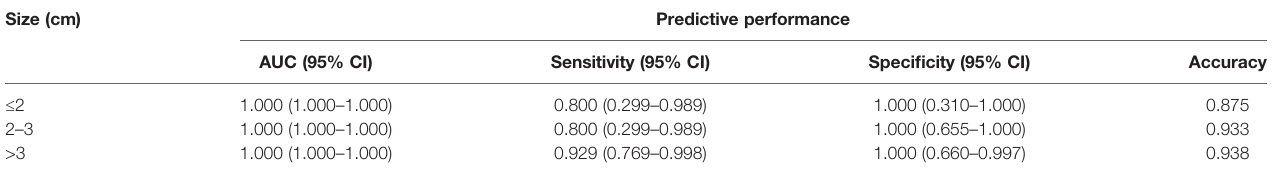
TABLE 4 | Predictive performance of radiomics nomogram in the strati fi cation veri fi cation according to the size in the validation cohort. Size (cm)